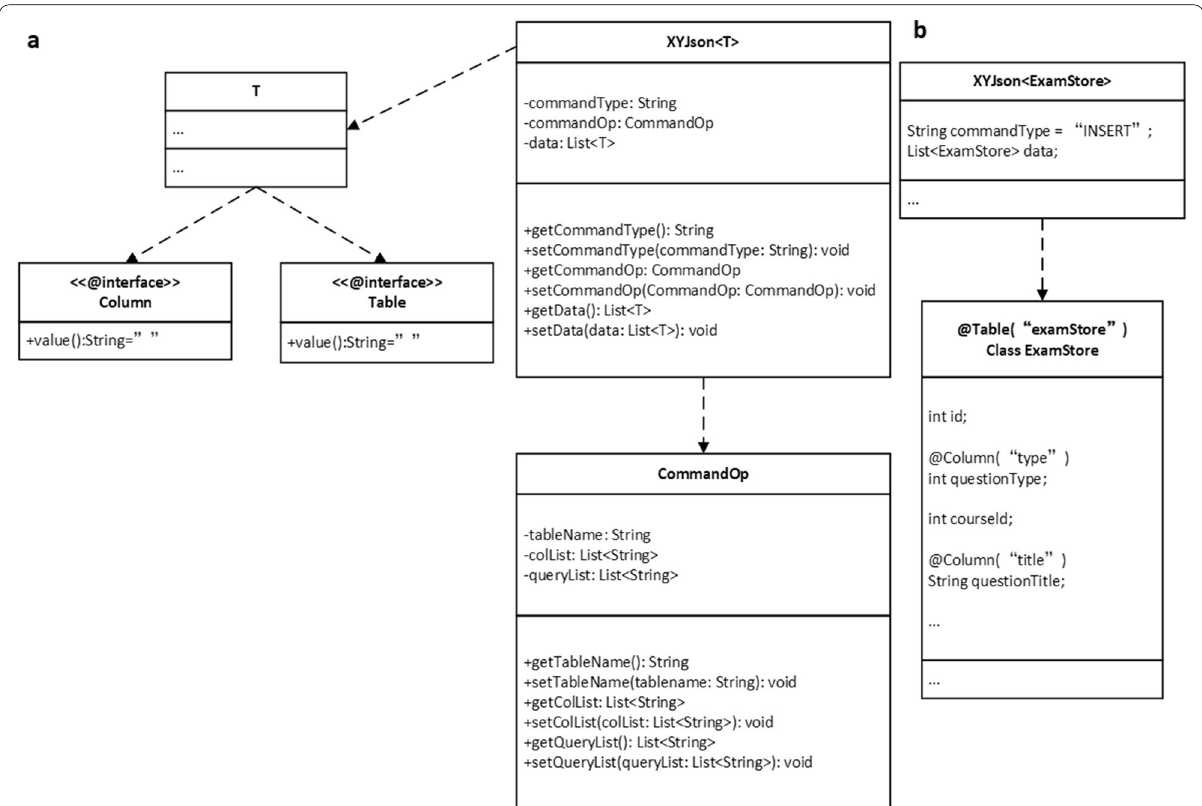
Fig. 3 XYJson control model structure and example ( a ) XYJson control model structure ( b ) Example of XYJson control model